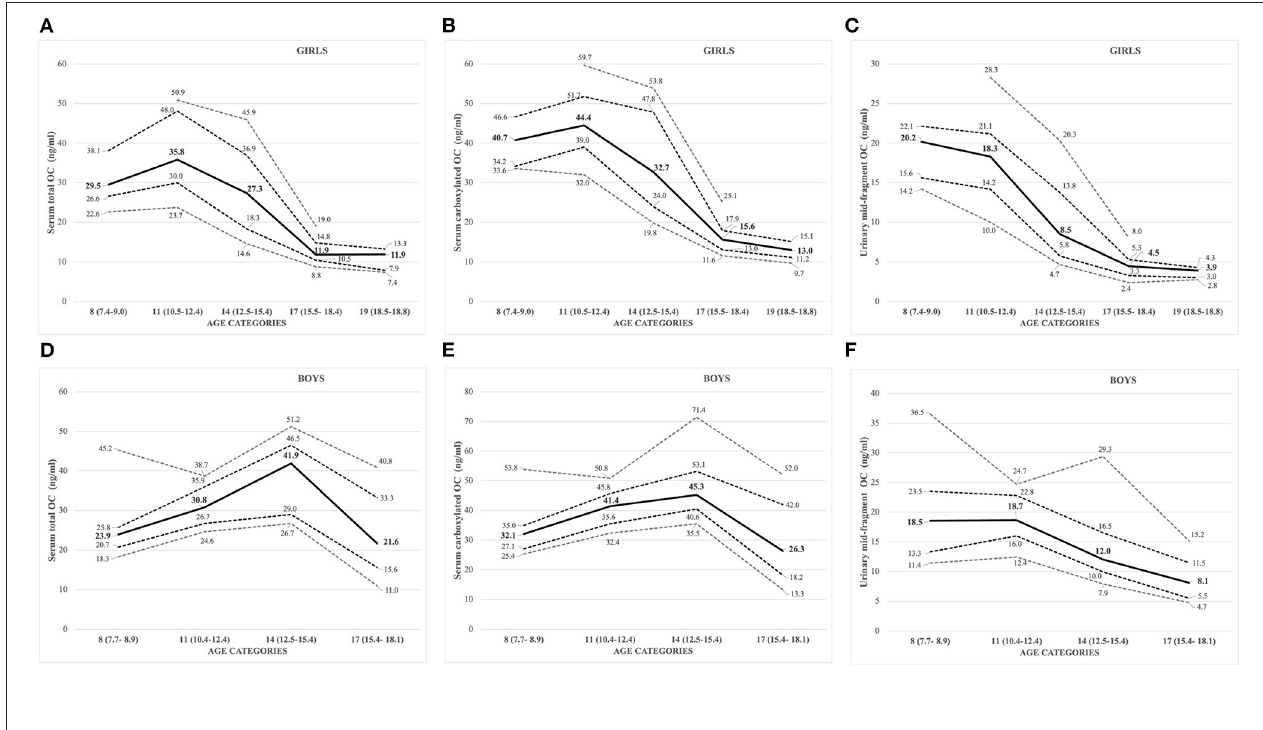
FIGURE 3 | (A–F) Sex- and age-specific OC concentrations displayed as percentiles (10th, 25th, 50th: solid line; 75th, 90th) for serum total OC [ (A) girls; (D) boys], carboxylated OC [ (B) girls; (E) boys], and urinary mid-fragment OC [ (C) girls; (F) boys].